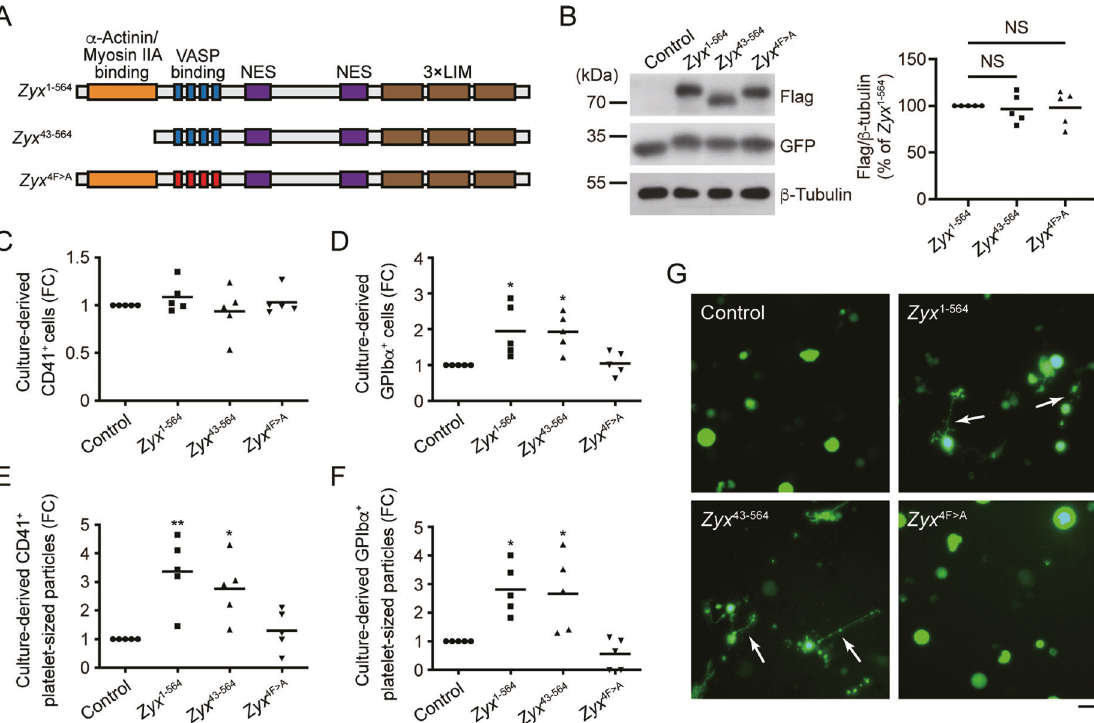
Fig. 7 The interaction of zyxin with VASP is required for zyxin-mediated GPIb α expression and platelet production. A Cartoons for the constructs of zyxin mutants lacking α -actinin and NMMHC-IIA ( Zyx 43 – 564 ), and VASP ( Zyx 4F>A ) binding sites. NES, nuclear export signals. B Zyx − / − FL HPCs were infected with adenoviruses expressing WT zyxin ( Zyx 1 – 564 ), zyxin mutants Zyx 43-564 and Zyx 4F>A , and vehicle vector (control). The expression levels of WT zyxin and zyxin mutants were determined by Western blot with an anti- fl ag tag antibody. The green fl uorescence (GFP) indicates the introduction of the plasmids into HPC-derived MKs. Blots are representative of fi ve independent experiments. C – F The expression of CD41 ( C ) and GPIb α ( D ) on culture-derived MKs was determined on day 4 by fl ow cytometry. The presence of CD41 + ( E ) and GPIb α + ( F ) platelet-sized particles released from culture-derived MKs was determined on day 5 by fl ow cytometry. FC, fold-change. Data are from fi ve independent experiments, and means are indicated by horizontal lines in ( B – F ). * P < 0.05, ** P < 0.01, compared with control by one-way ANOVA followed by Dunnett ’ s post hoc test. NS, not signi fi cant. G Representative fl uorescent microscopy images of